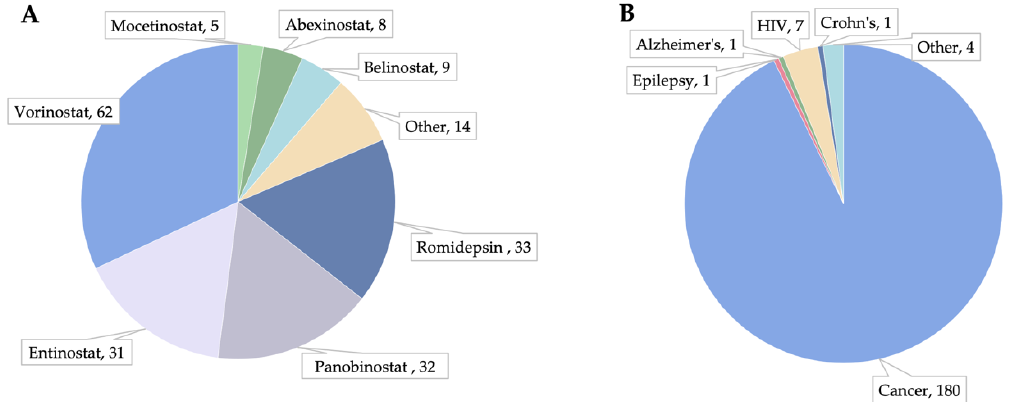
Figure 3. HDAC inhibitor interventions in ongoing US clinical trials (194 total; ( A )) and their investi- gated conditions/diseases ( B ), retrieved from clinicaltrials.gov on 22 November 2021. Completed, withdrawn, and/or terminated studies were excluded.